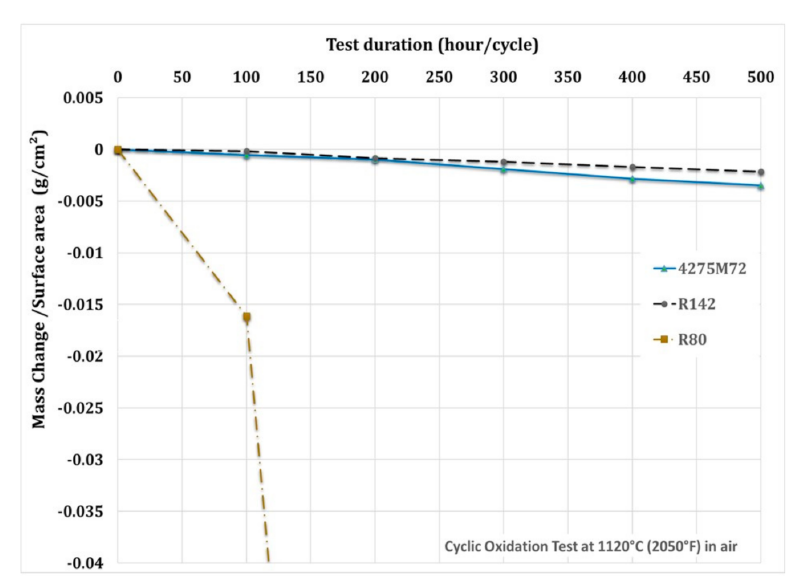
Figure 13. Cyclic oxidation resistance of LDEDed 4275M72 compared to R142 and R80 welds at 1120 ◦ C (1393